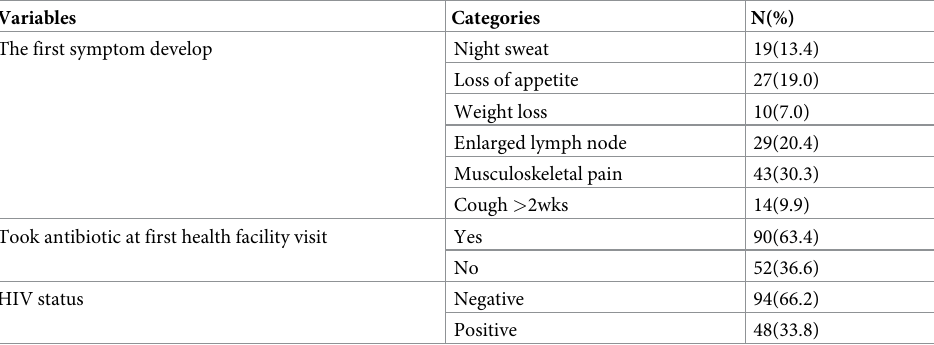
Table 2. Clinical characteristics of EPTB patients at public health facilities of North Shewa zone, Ethiopia, April 2021.